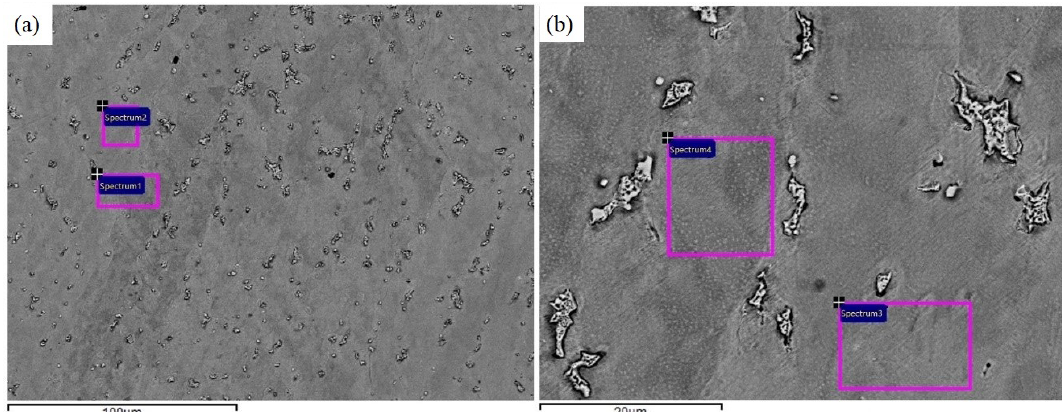
Figure 18. Inspection results of the high-definition backscattered electron detector (HDBSD) and energy-dispersive X-ray spectrometer (EDS) in the weld